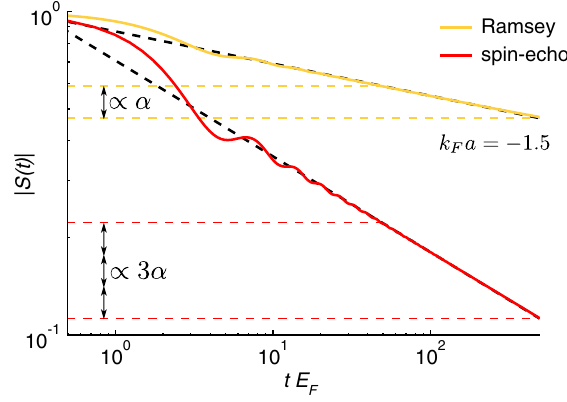
FIG. 6. The spin-echo response, Eq. (19), of the Fermi gas. At long times, it is characterized by a power-lawdecay, Eq. (20), with an exponent that is 3 times larger than that of the standard